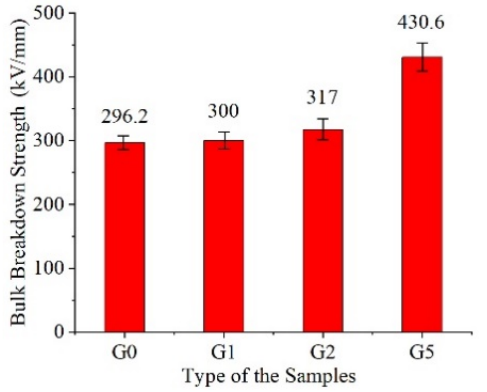
Figure 12. Bulk breakdown